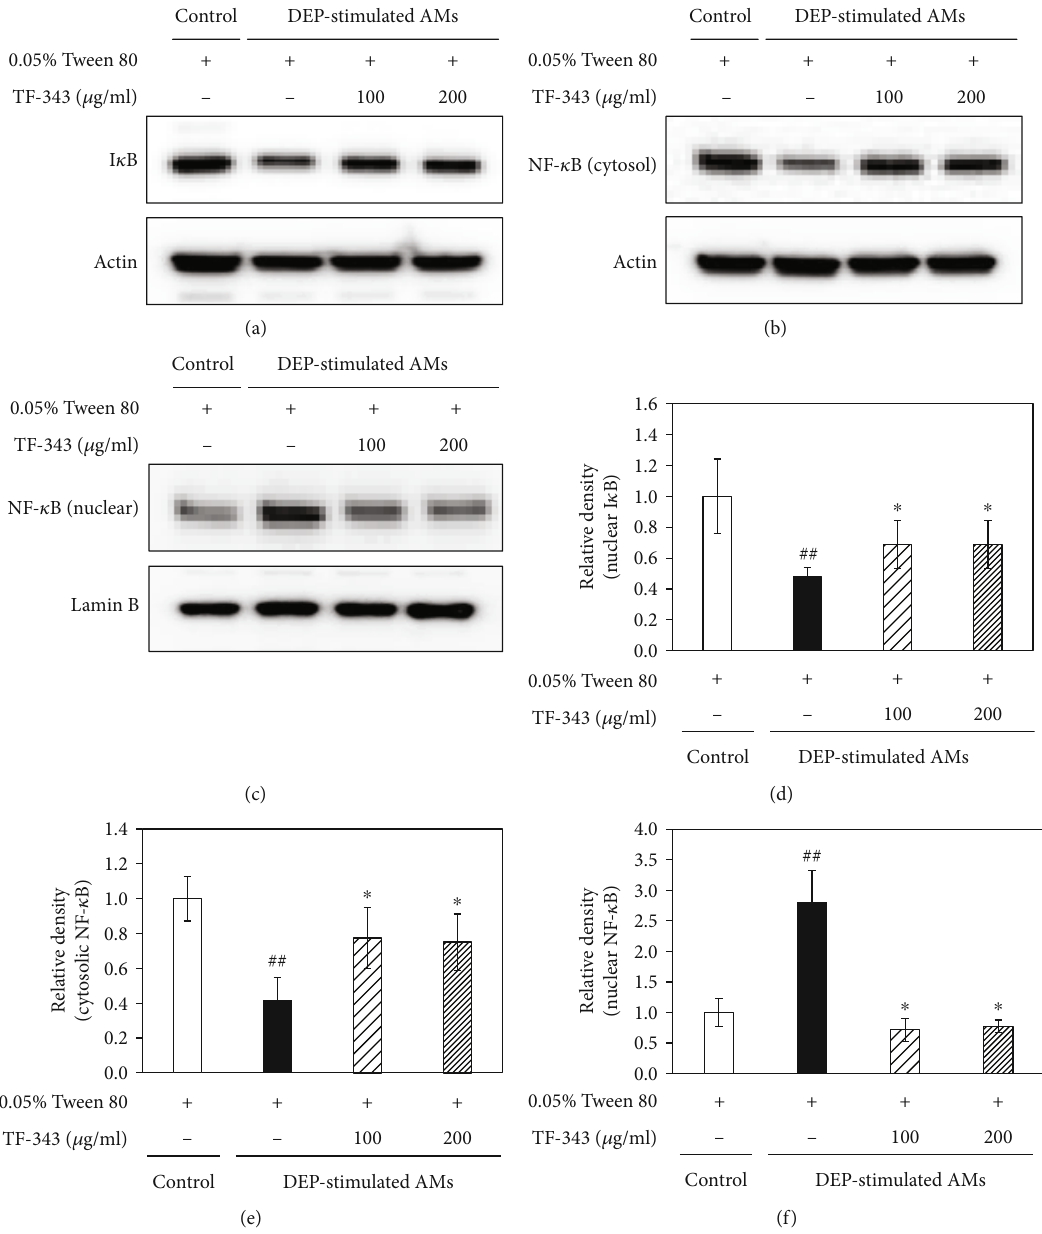
Figure 7: (a – c) Representative western blots and (d – f) relative density of I κ B and NF- κ B in DEP-stimulated AMs. Data represent the mean ± SD ( n = 5 per group). ## P < 0 : 01 vs. control, ∗ P < 0 : 05 vs. DEP-treated